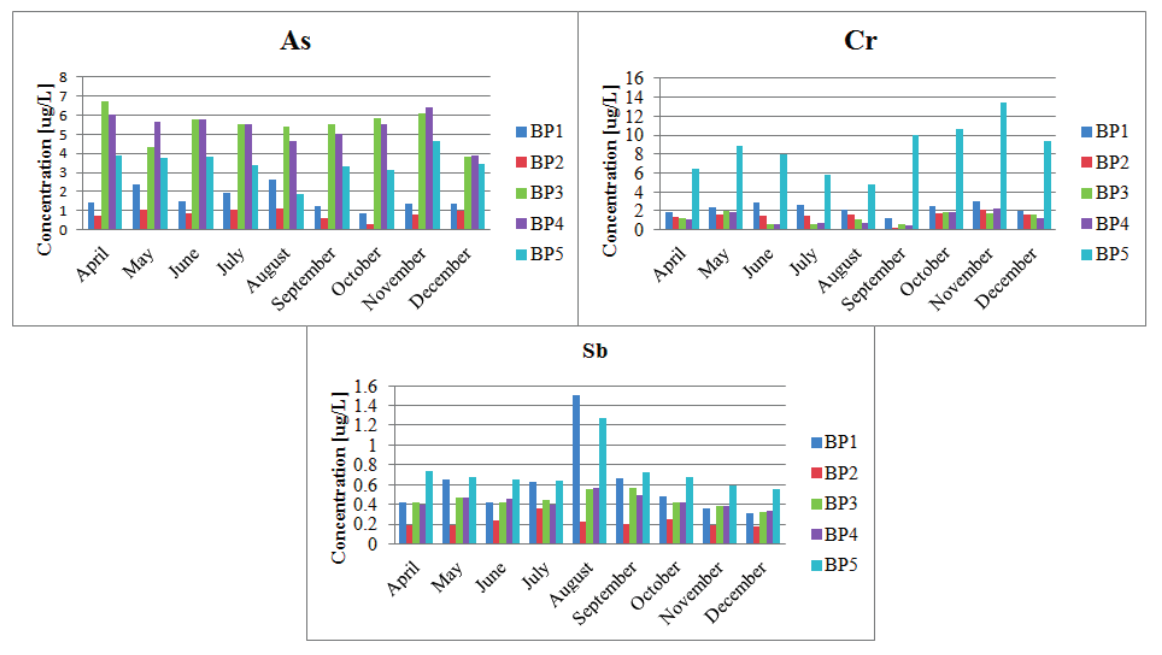
Figure 3. Total contents of arsenic, antimony and chromium in the Bia ł a Przemsza River water; sampling points: BP1—Chrz ą stowice; BP2—Klucze Osada; BP3—D ą browa Górnicza Okradzionów; BP4—S ł awków;